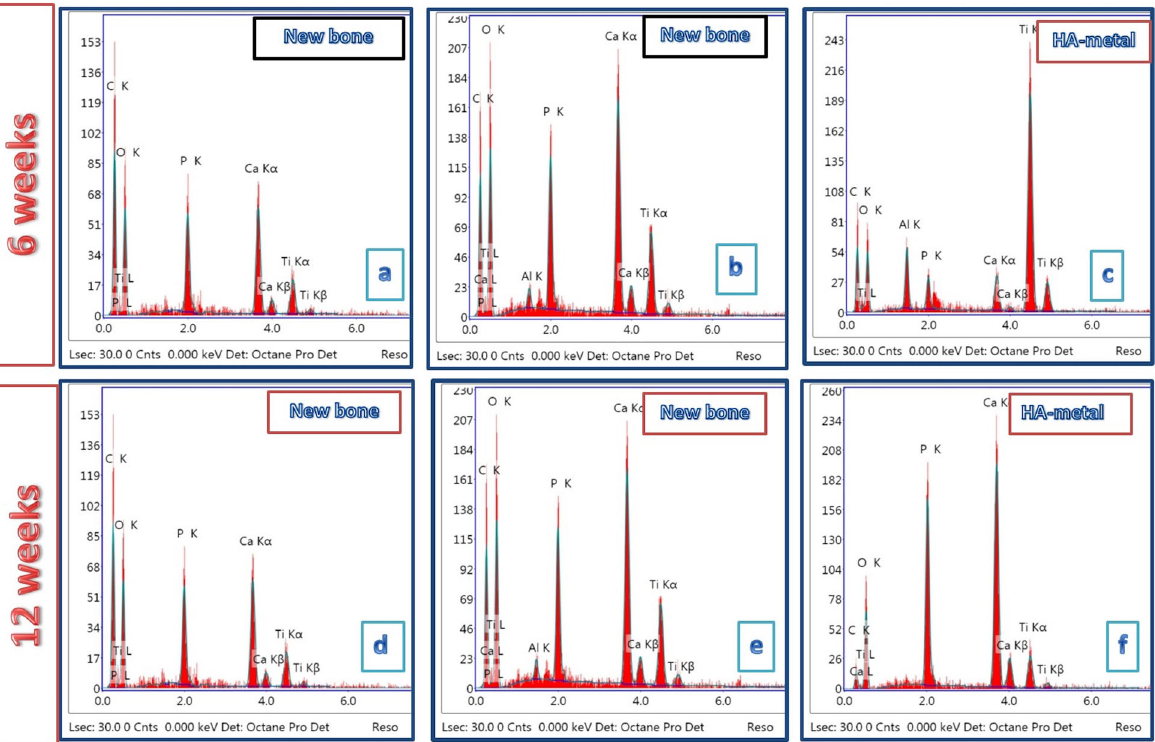
Fig. 7 EDX analysis at 12 weeks post surgery: a – c (control group GI), Ti/Al alloy coated (bHA) GIII) for 6 weeks and (bHA) coat metal alloy, d – f (control group GII), TI/Al/ alloy coated with (bHA) GIV)